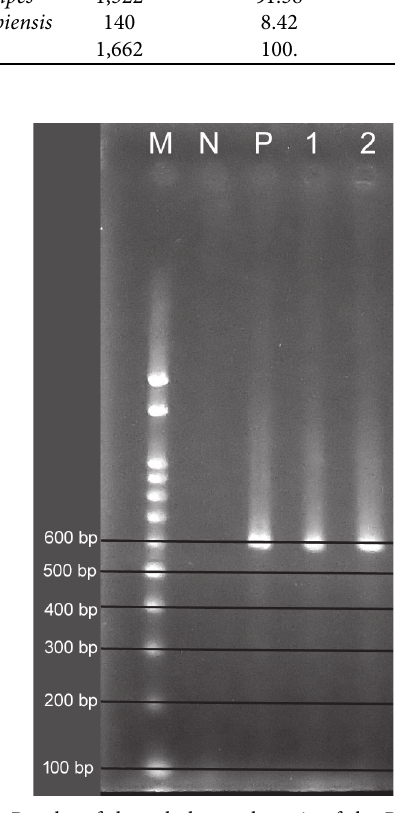
Figure 2: Results of the gel electrophoresis of the PCR products amplified with Leishmania donovani specific primers. M: 100bp marker DNA ladder, N: negative control, P: positive control; (1) and (2) positive sand fly